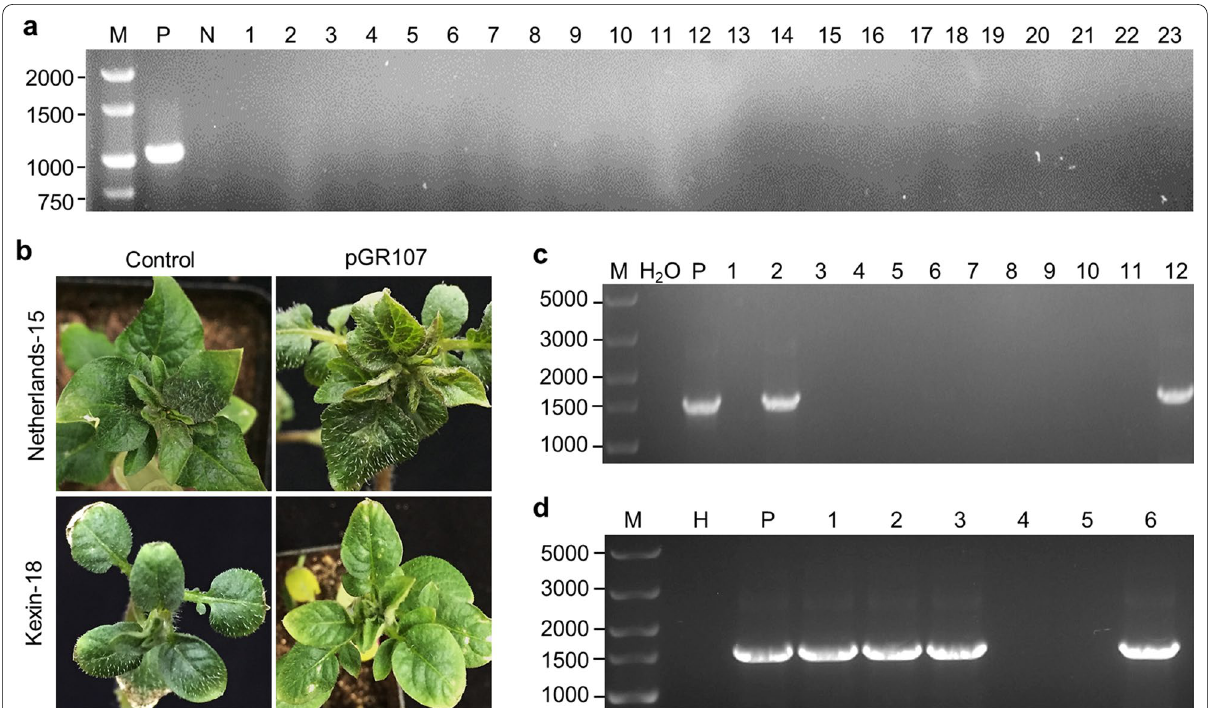
Fig. 1 Symptoms and detection of PVX in different potato cultivars. a RT-PCR analysis of the presence of PVX in potato plantlets using primer pair pvx-tgb2-f and PVXcpRT-R. M, DL2000 DNA marker (Vazyme); P, PVX-infected Nicotiana benthamiana leaf tissues (positive control); N, healthy N. benthamiana leaf tissues (negative control). Potato cultivars were arranged in the same order as in Table 1. b PVX symptoms on plantlets of Netherlands-15 and Kexin-18 at 12 dpi. c RT-PCR analysis of the presence of PVX in the systemic leaves of potato plantlets using primers PVX5875-F and PVXcpRT-R at 15 dpi. Lanes 1, 3, 5, 7, 9 and 11 are healthy Kexin-1, Atlantic, Eugene, Waiyin-2, Longshu-3 and Waiyin-1, respectively; lanes 2, 4, 6, 8, 10 and 12 are PVX-infected Kexin-1, Atlantic, Eugene, Waiyin-2, Longshu-3 and Waiyin-1, respectively. d Detection of PVX genome in Waiyin-1 and Kexin-1 using primers PVX5875-F and PVXcpRT-R at 9, 12 and 15 dpi. H, Healthy Kexin-1; P, positive control (PVX-infected N. benthamiana leaf tissues); lanes 1, 2 and 3 are systemic leaves of Kexin-1 agroinfiltrated with pGR107 at 9, 12 and 15 dpi, respectively; lanes 4, 5 and 6 are systemic leaves of Waiyin-1 agroinfiltrated with pGR107 at 9, 12 and 15 dpi,